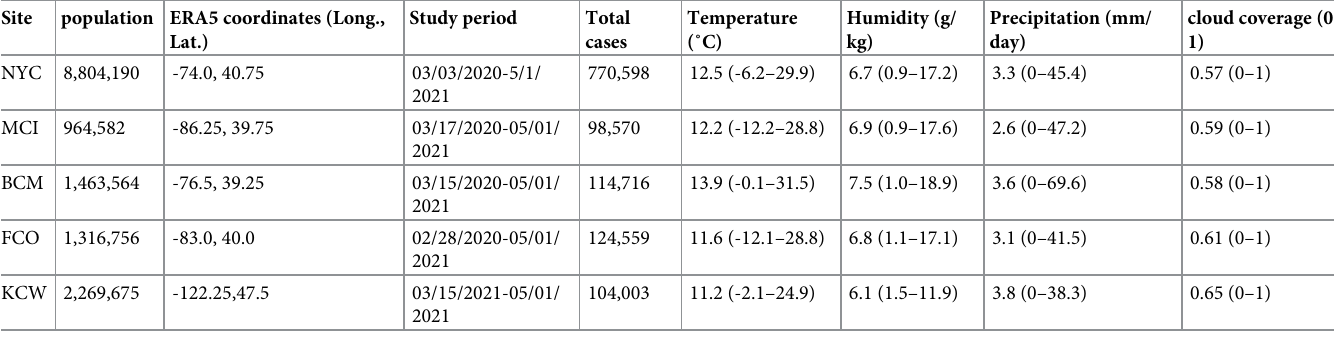
NYC: New York City; MCI: Marion County, Indiana (including Indianapolis); BCM: Baltimore County, Maryland (including Baltimore), Franklin County, Ohio (including Columbus), KCW: King County, Washington (including Seattle). For temperature, humidity, precipitation and cloud coverage mean values and ranges over the study period are